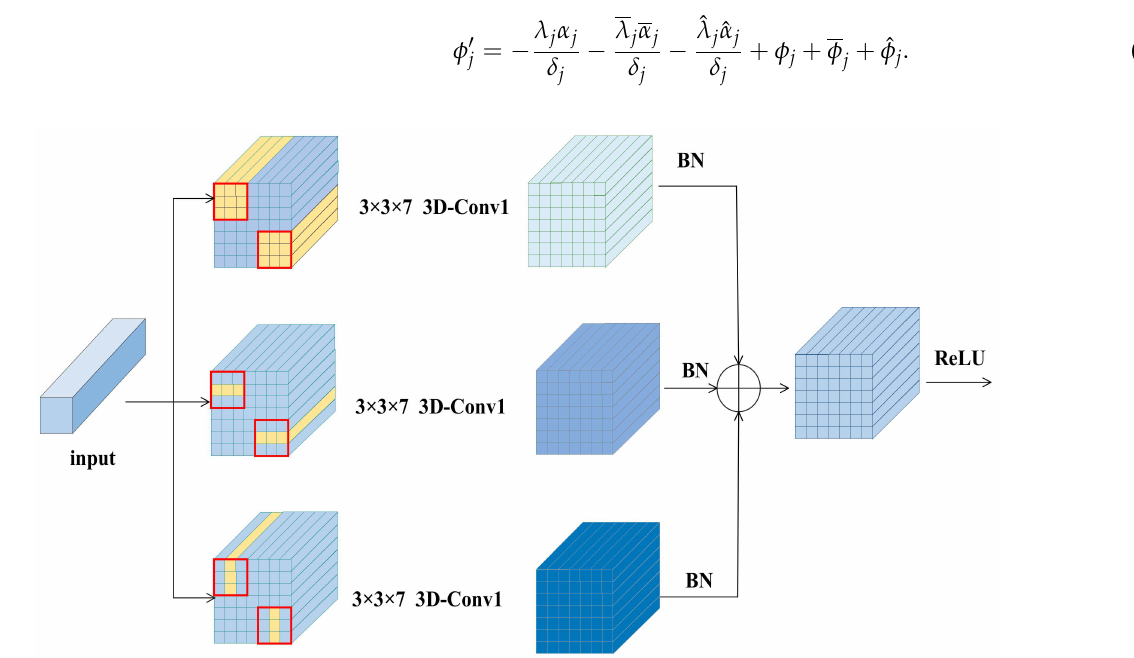
Figure 6. Schematic diagram of multiscale asymmetric